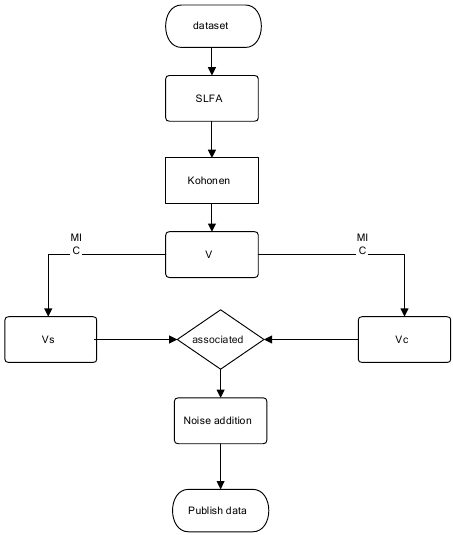
Figure 4. Detailed flow chart of the proposed method.